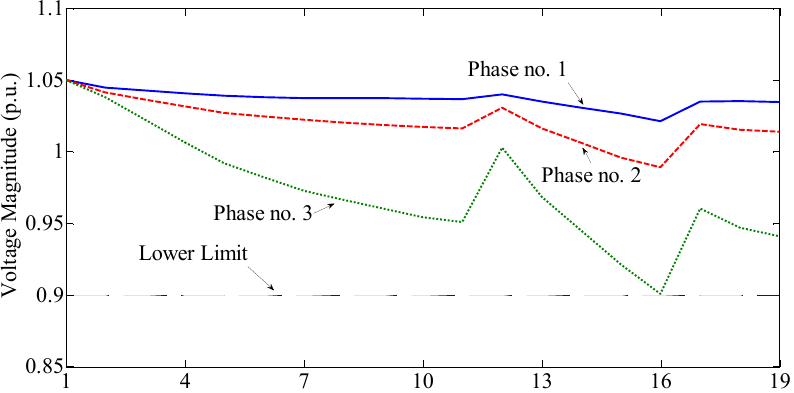
Figure 11. Case Study 3: Line currents of the residential feeder (phase no.1) at hour 21.00 of the last typical day.